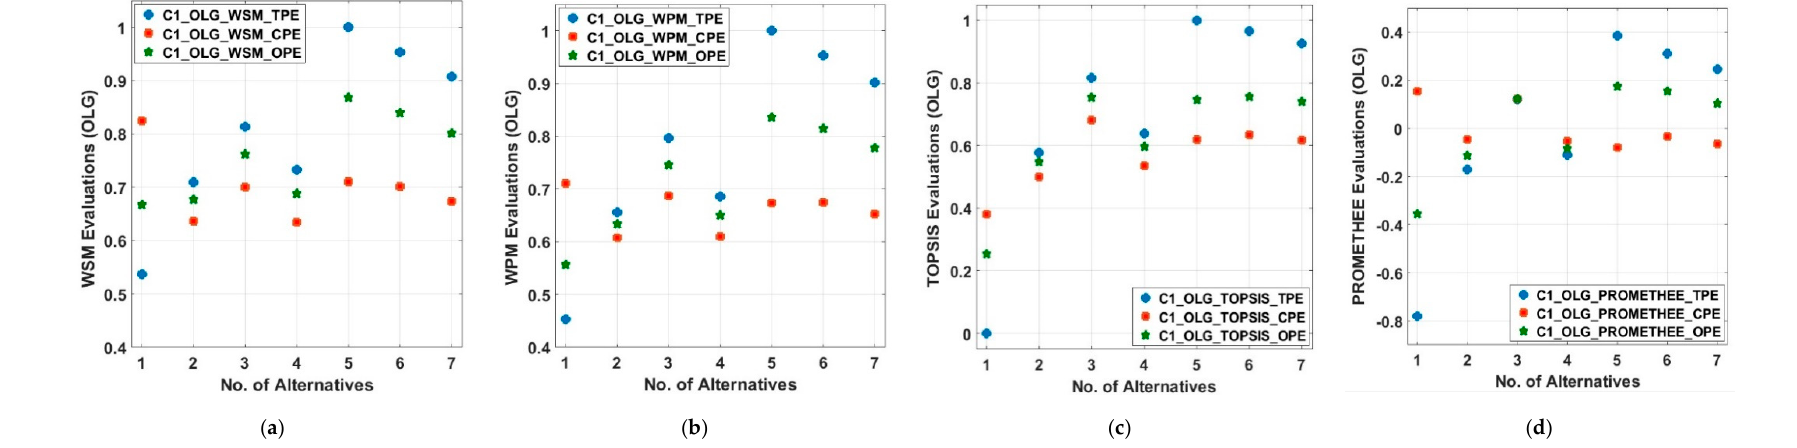
Figure 13. MCDM evaluations for C1_OLG in 33-bus MDN: ( a ) WSM scores; ( b ) WPM scores; ( c ) TOPSIS scores; ( d ) PROMETHEE scores. Table 22. Order of the ranks across TPE, CPE, and OPE in C1_OLG for 33-bus